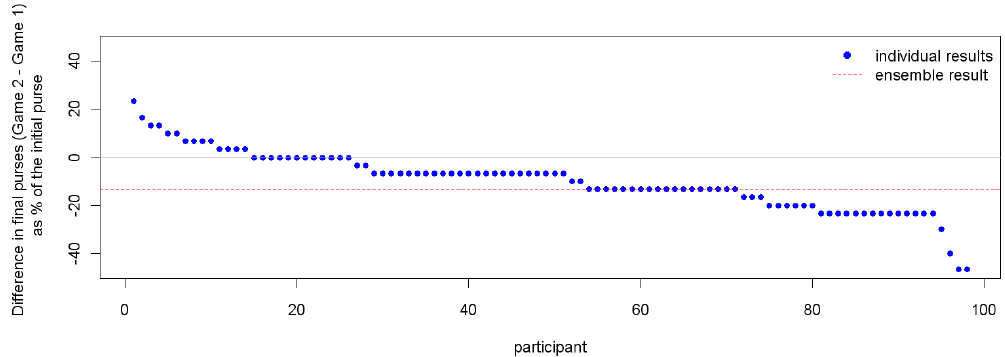
Fig. 6. Ranked differences in final purses (as percentage of the initial purse, % 1P 2 − 1 ) for the 98 participants and the “ensemble result”. Differences < 0 mean that more money was lost when decisions were made without uncertainty information than with it, and vice-versa.